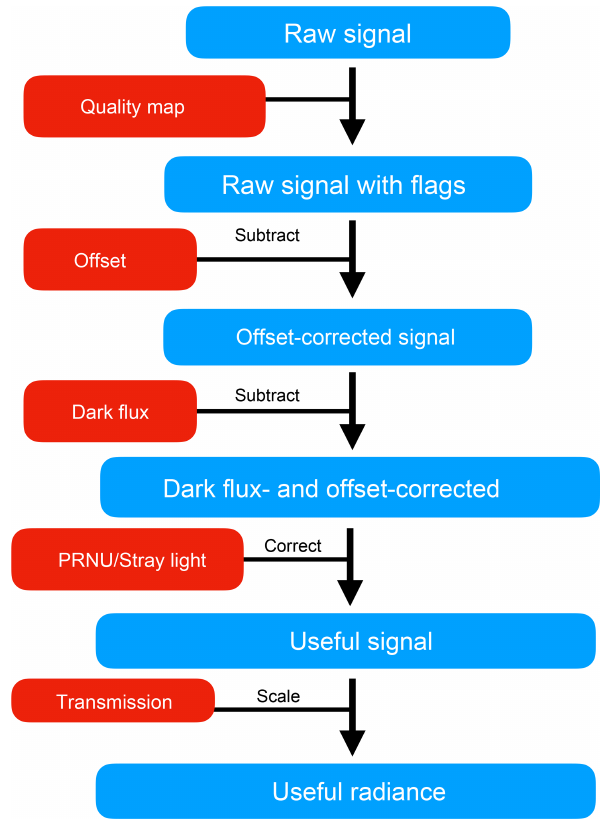
Figure 2. Summary flow chart of the processing chain of a SWIR signal. This describes the processes that require monitoring in- flight. It assumes unit conversions are correctly carried out to pro- duce useful radiance in spectral radiance